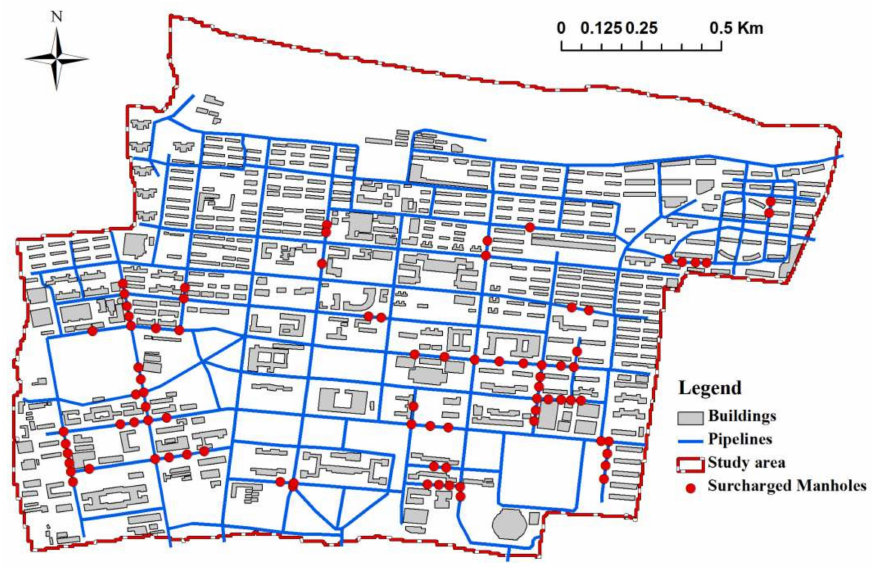
Figure 12. Simulation results of the 1D channel flows of the sewer